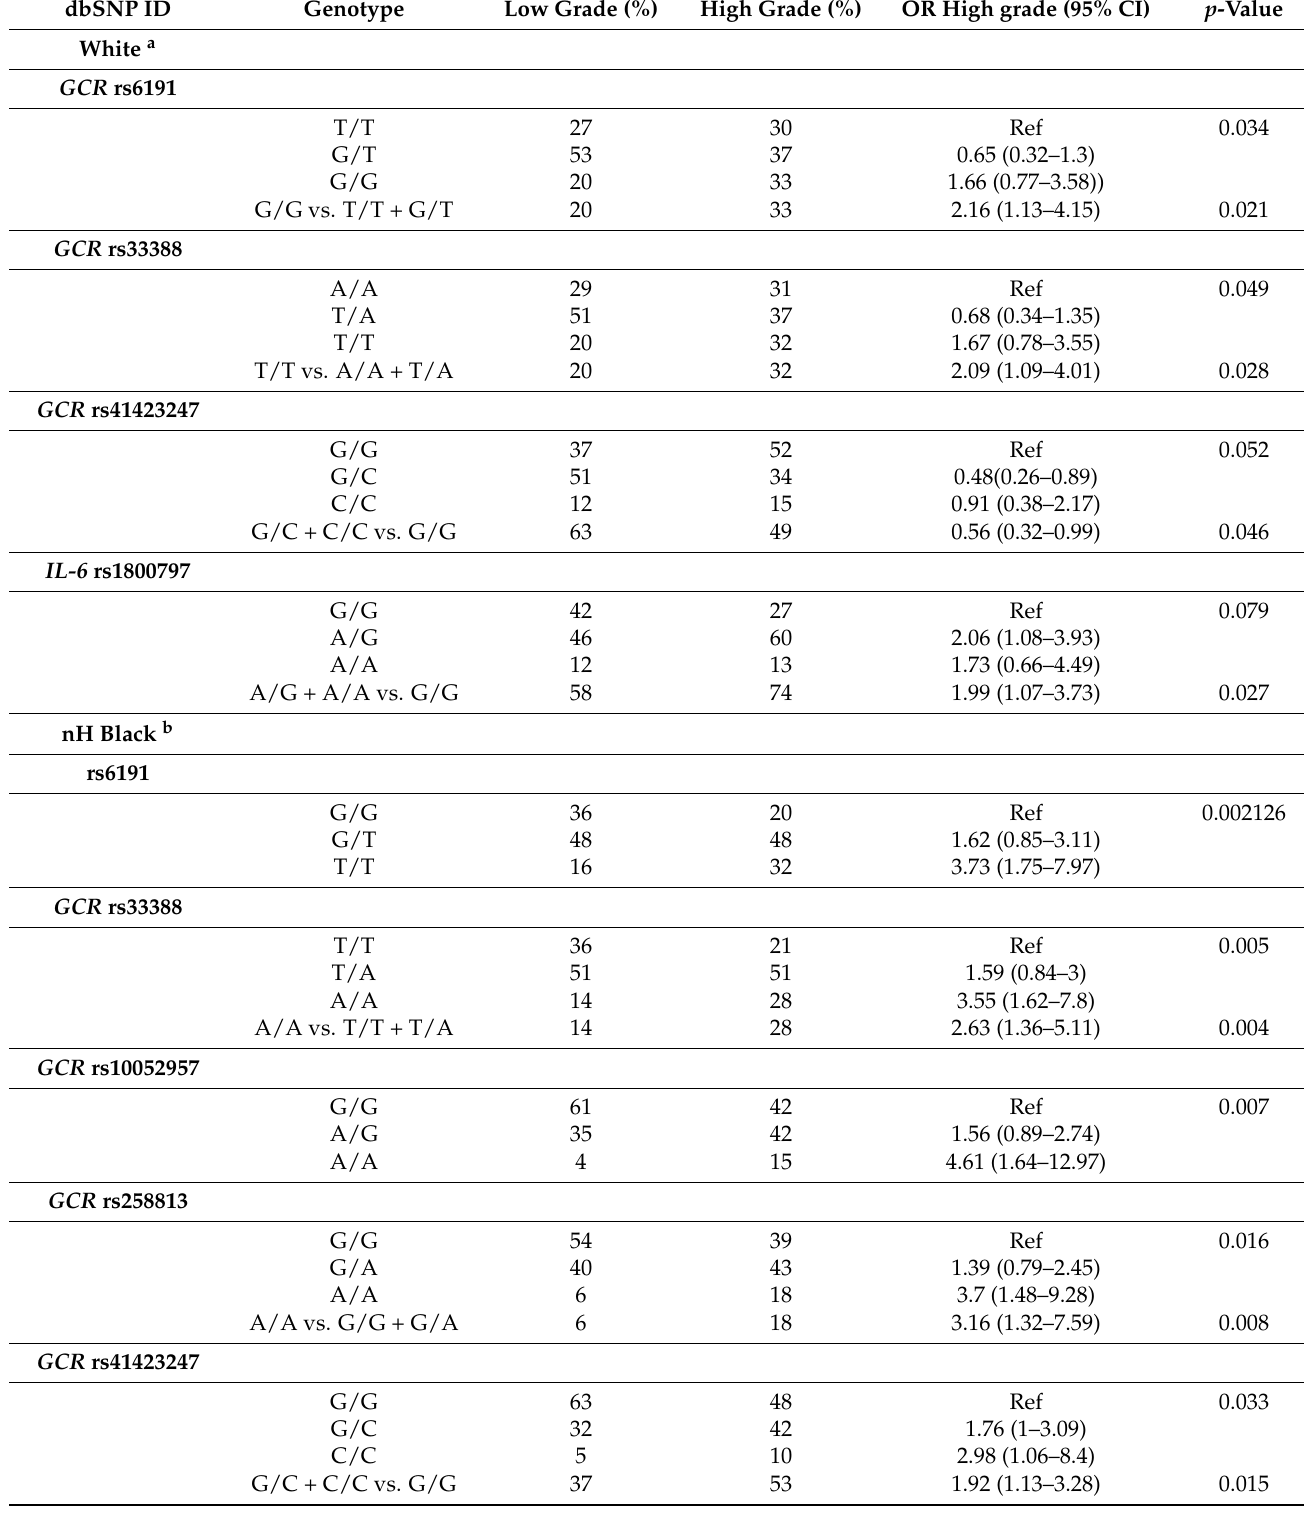
Table 2. SNPs with a significant association with a higher grade at diagnosis ( p <